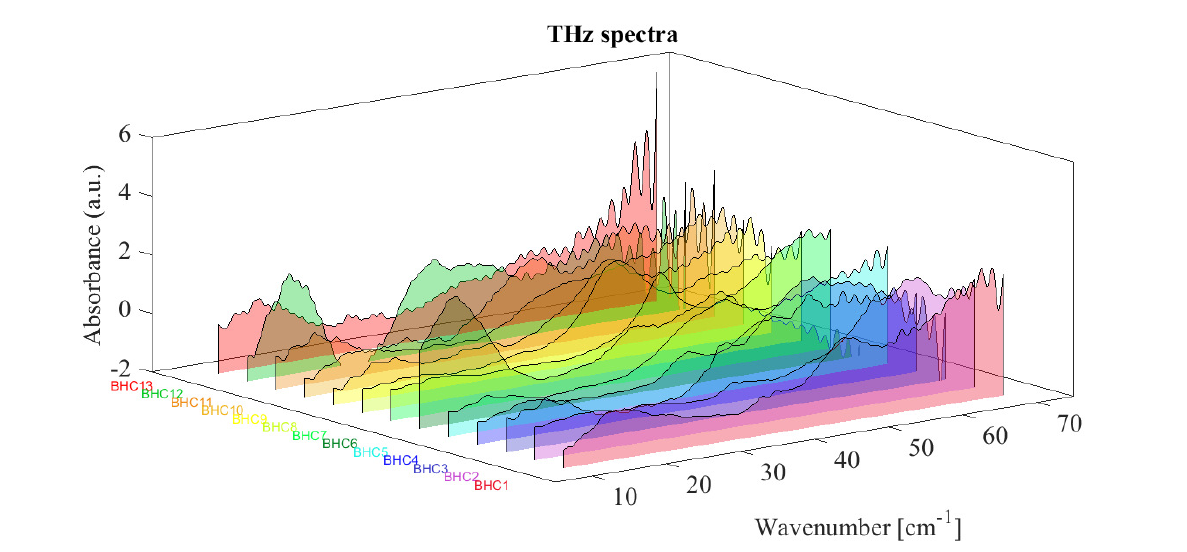
Figure 3. THz spectra of tested bi-heterocyclic